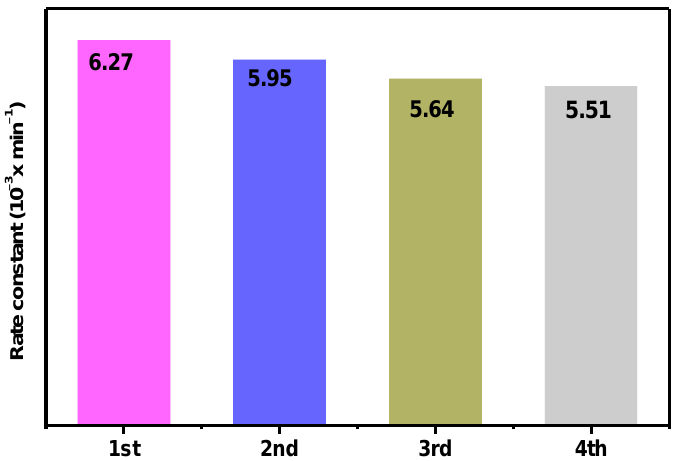
Figure 10. The pseudo first-order rate constants of the investigated Mn-CeO 2 (10%) sample in four consecutive runs.